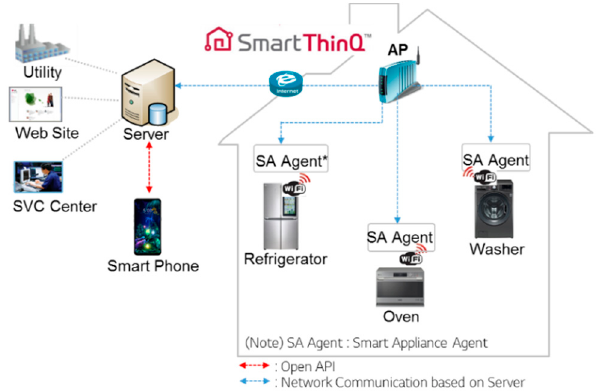
Figure 1. Smart ThinQ®.